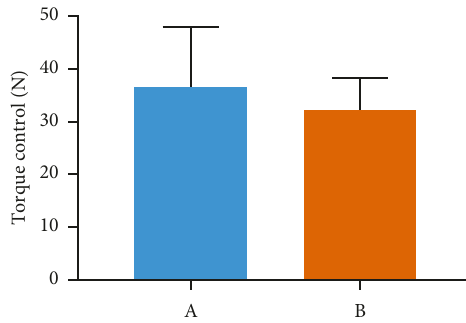
Figure 1: Torque control for the installation of implants in two different groups. A: osseointegrate failure (OF) group; B: control